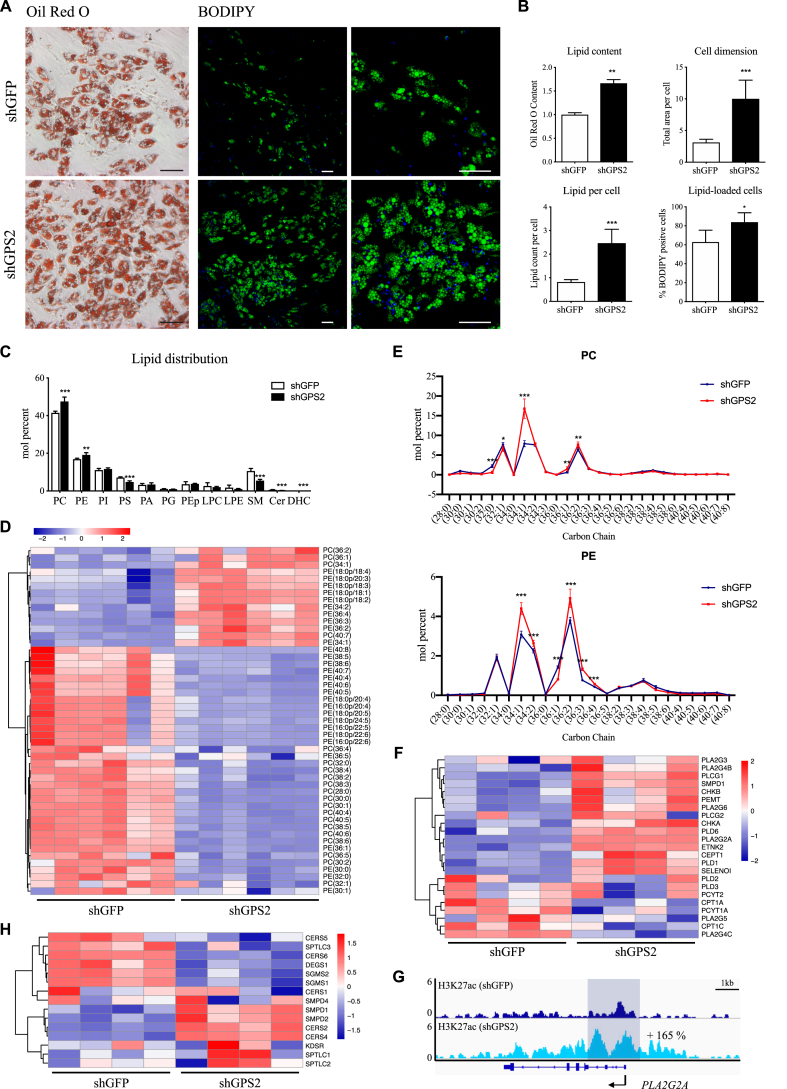
GPS2 depletion increases lipid accumulation, phospholipid accumulation, and sphingolipid depletion. (A) Representative images of Oil Red O staining and BODIPY immune-fluorescence staining conducted at day 14 in shGFP and shGPS2 cells. Scale bars, 100 μm. (B) Quantification of ORO staining (n = 3), quantification of cell dimension, lipid droplets per cell, and percentage of lipid-loaded cells (n = 5). (C) Distribution of lipid classes expressed as mol% of total phospho- and sphingolipids measured in shGFP and shGPS2 adipocytes (n = 6). (D) Heatmap of PC and PE species altered (FDR < 0.05) in shGFP and shGPS2 adipocytes (n = 6). (E) PC and PE species composition in shGFP and shGPS2 mature adipocytes (n = 6). (F) Heatmap of differentially expressed genes involved in PC and PE synthesis in shGFP vs shGPS2 adipocytes at day 14 (n = 4). (G) ChIP-seq tracks of H3K27ac at the PLA2G2A locus; the percentage of increase (shGPS2 vs shGFP) represents the area under the curve. (H) Heatmap of differentially expressed genes involved in Cer and SM synthesis in shGFP vs shGPS2 adipocytes at day 14 (n = 4). All of the data are represented as mean ± standard deviation (SD) (n = 3-5-6). ∗p < 0.05, ∗∗p < 0.01, ∗∗∗p < 0.001, and Student's t-test.